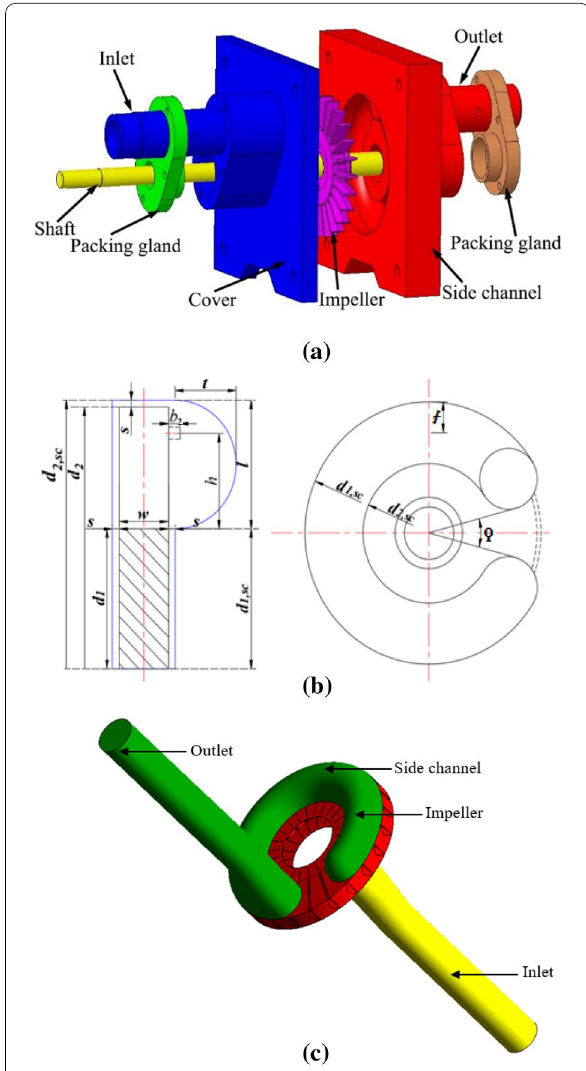
Figure 1 Side channel pump model ( a ) 3D, ( b ) 2D, ( c ) Entire computational